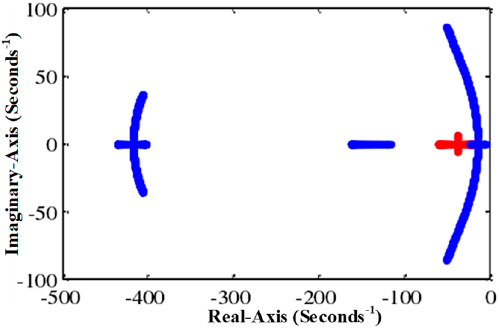
Figure 3. Pole distribution of motor under rated speed after designed. The blue line is the pole distribution of the motor below the rated speed solved by the determinant equation det ( sI − P ) = 0 under the fifth-order equation of the state, and the red line is the pole distribution of the motor below the rated speed solved by the reduced-order equation det [ sI − ( P 11 + KP 21 )] = 0 under the determinant equation. As can be seen from the figure, the selection of feedback matrix K meets the design requirements, and the stability of the system can still be guaranteed after the reduced-order observer design method is adopted.